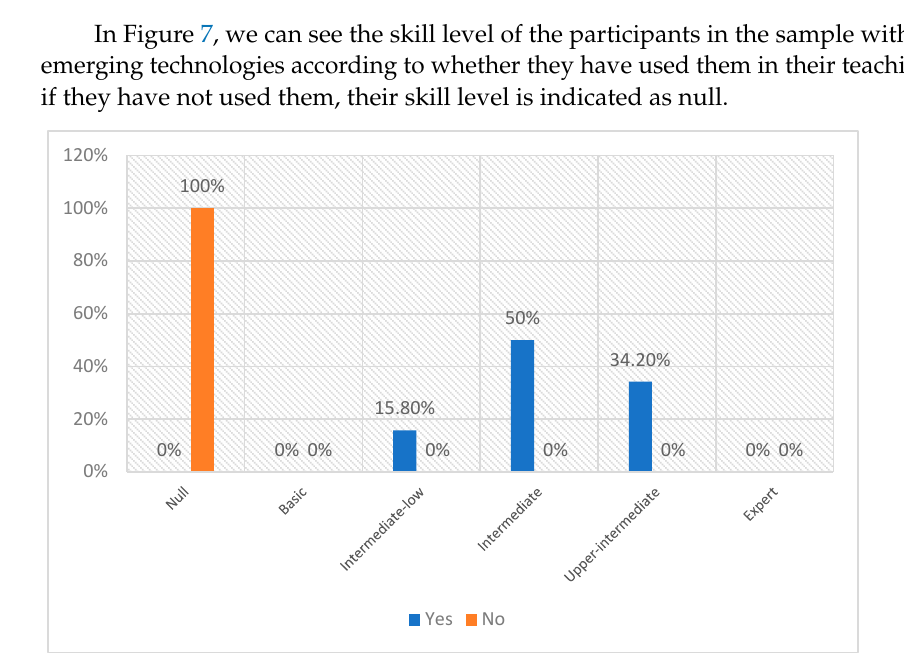
Figure 7. Skill level by use of Emerging Technologies.